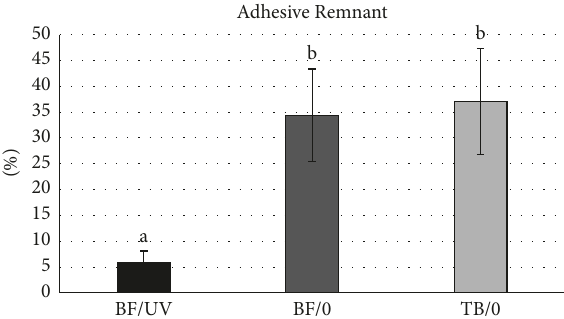
Figure 4: Means (SD) of the time used by the dentists to remove the adhesive remnant for all groups and results of Tukey’s test. Different letters in columns show significant differences.